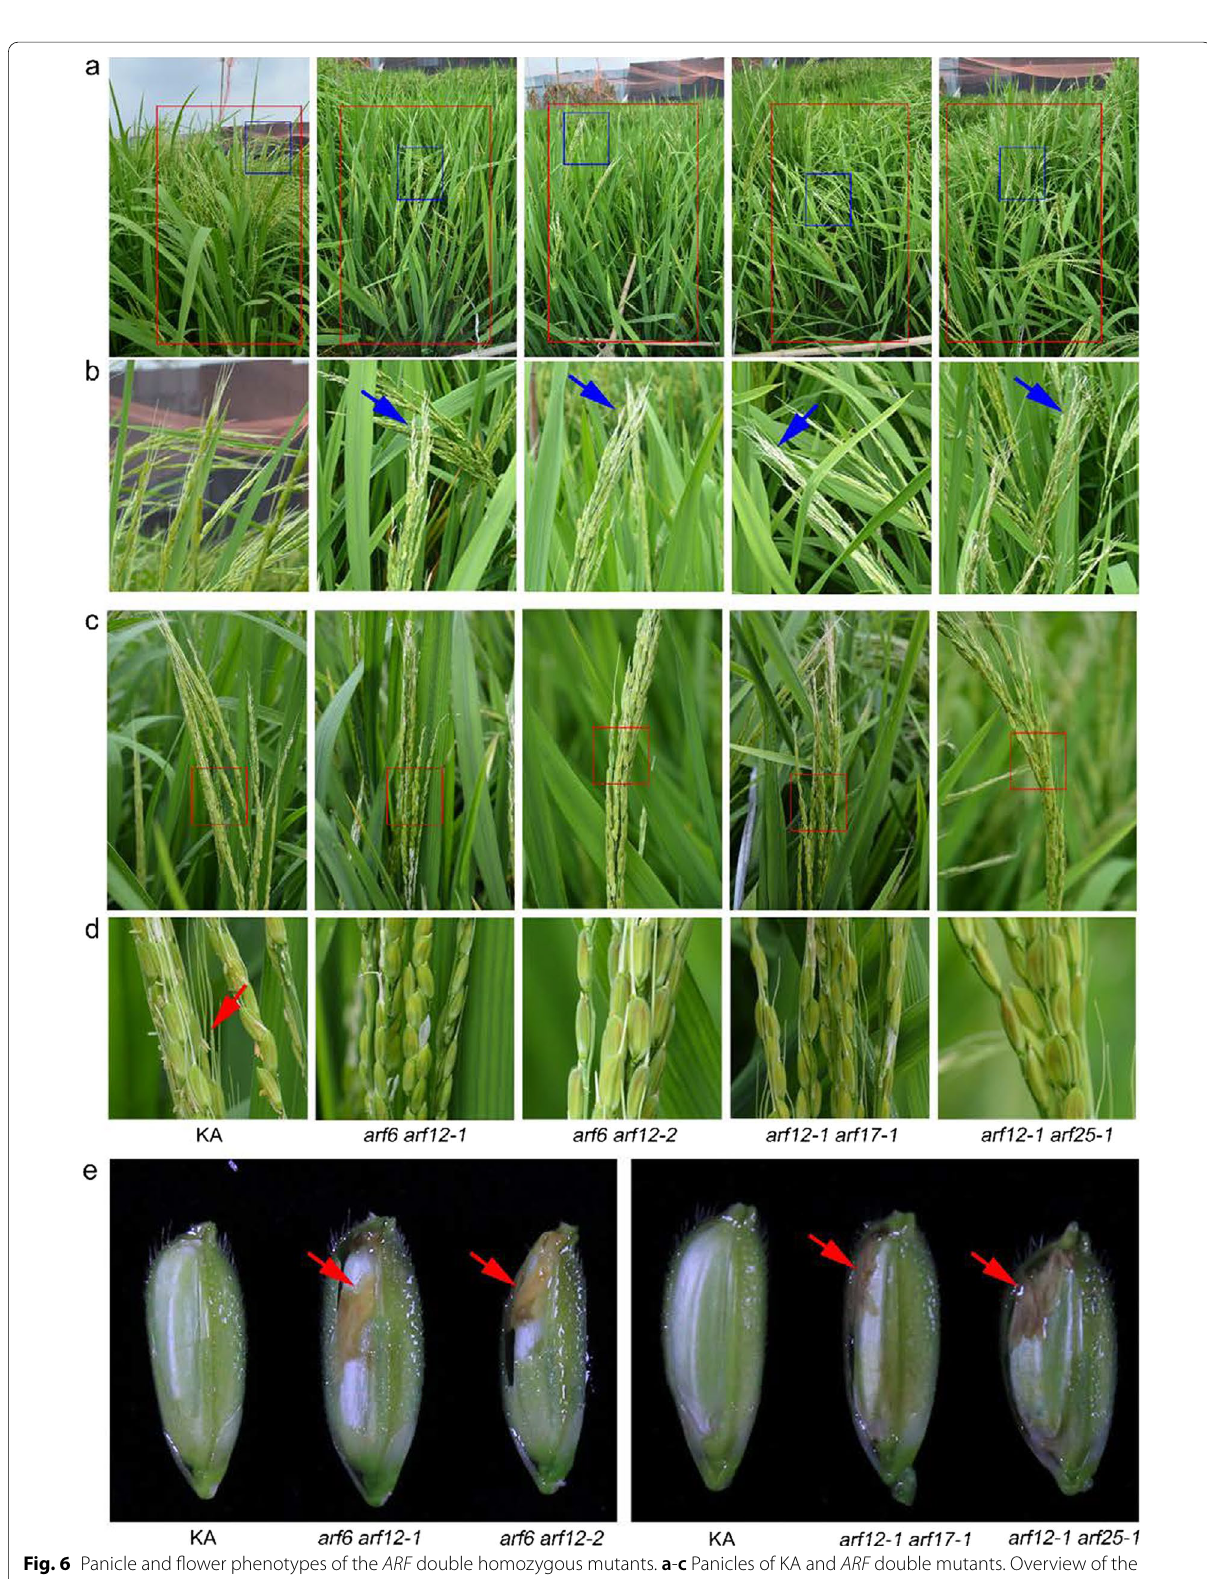
Fig. 6 Panicle and flower phenotypes of the ARF double homozygous mutants. a ‑ c Panicles of KA and ARF double mutants. Overview of the panicles ( a ). Close‑up view of the panicles ( b – c ). Blue arrows indicate aborted apical spikelets. d Zoom‑in view of the red box in ( c ). Red arrows indicate the anthers that move out from the flowers. e The inner view of the flowers at the later grain filling stage. Red arrows indicate